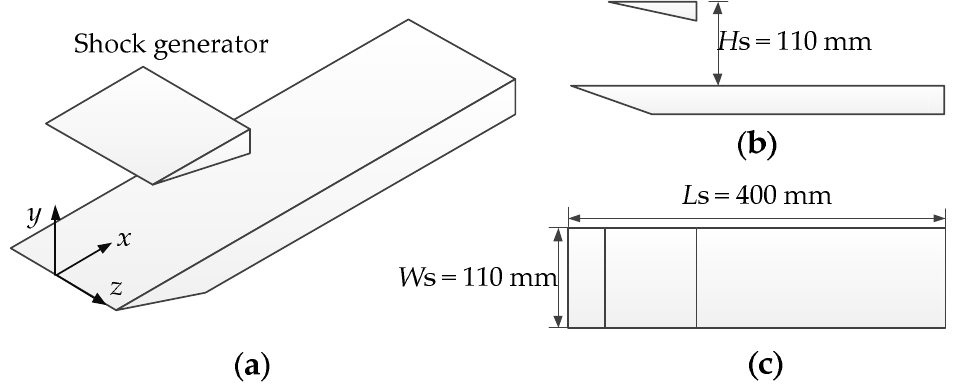
Figure 5. Computational model of ISWBLI: ( a ) 3D view; ( b ) front view; ( c ) top view.